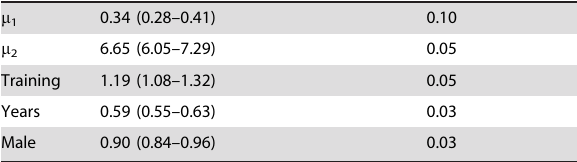
Table 3. Submission pattern model parameter estimates reported as rate